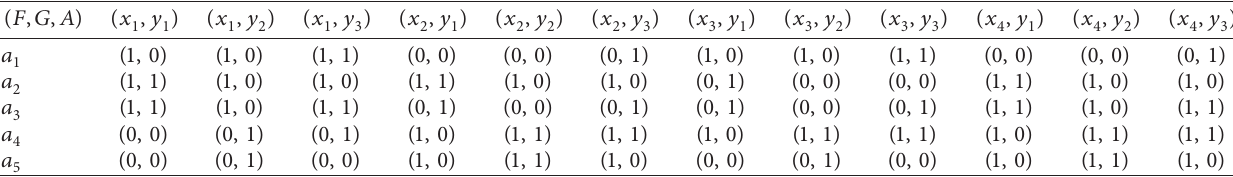
Table 3: Tabular expression of the T-bipolar soft set ( F,G,A ) .